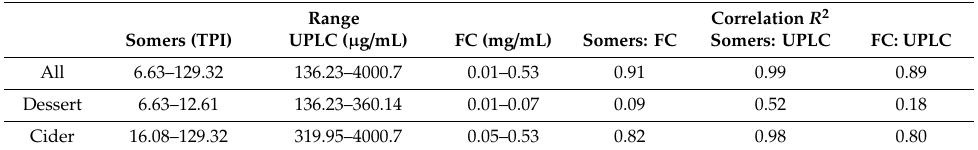
Table 1. The range in total phenolics values and the correlation ( R 2 ) between methods for all varieties and both variety types ( n = 77 all, 36 dessert, 41 cider). FC results are expressed as mg p -Coumaric acid equivalents/mL.